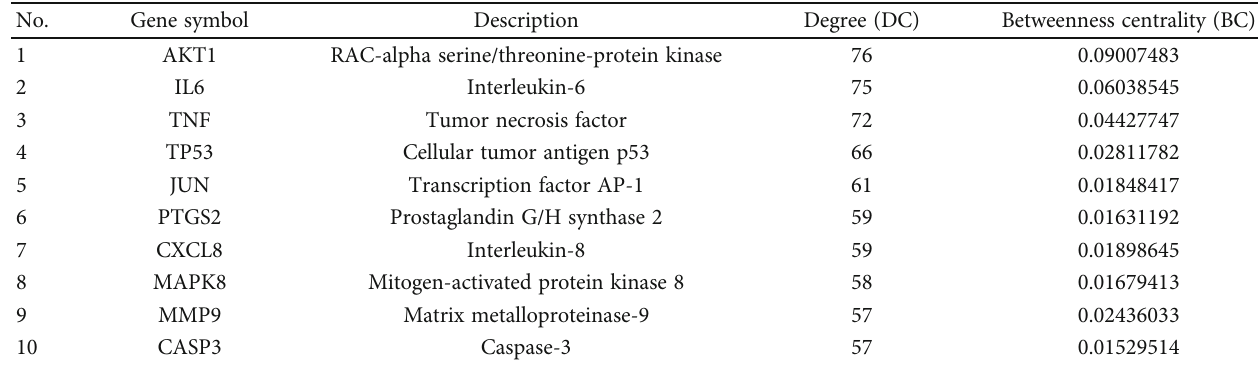
Figure 3: The protein-protein interaction (PPI) network analyze of overlapping targets. The color and depth of the nodes (orange → yellow → green) are in descending order of degree values, and node sizes are proportional to their degree. Table 3: Ten key targets of ABM in treating